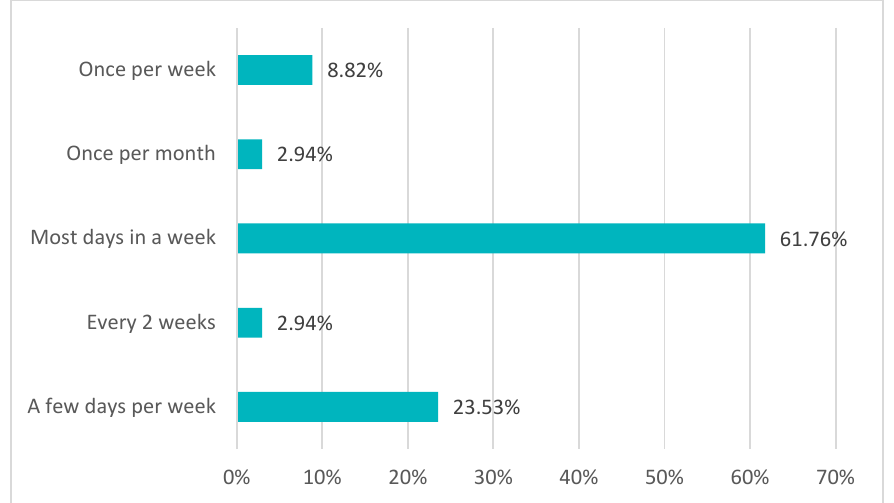
Figure 15. Frequency of trips up to 50 Km per daily.